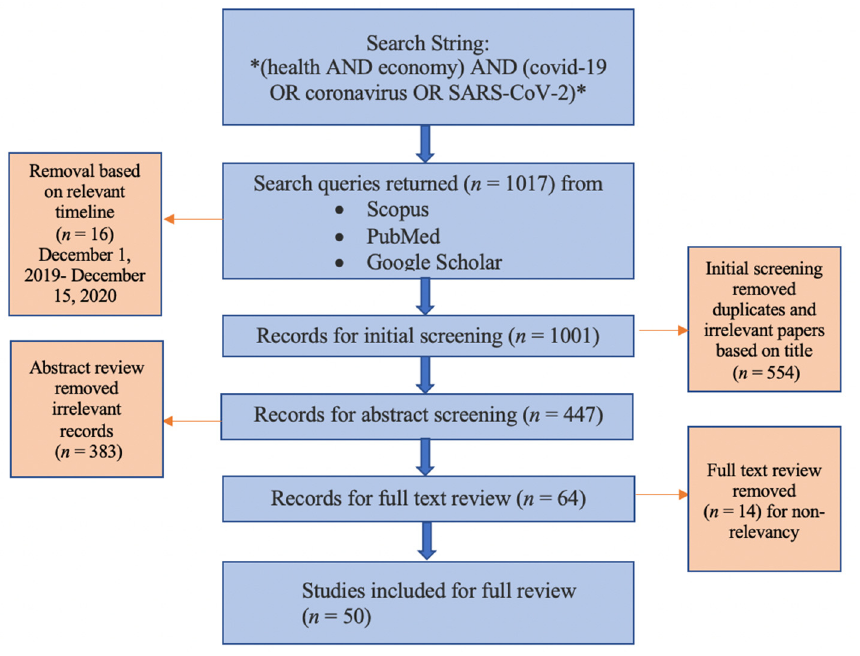
Figure 1. Method flow chart.